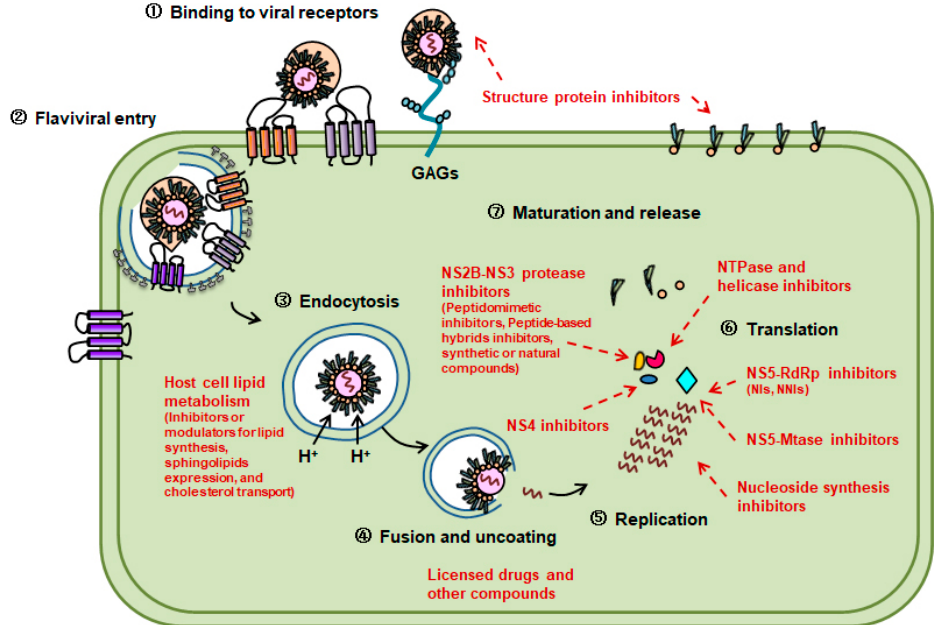
Figure 1. Flavivirus replication cycle and the targeted antiviral strategies. The virion binds to the surface of the host cell through specific receptors and is internalized into the host cell by clathrin- mediated endocytosis. Flavivirus is then uncoated, and its genome is released into the cytoplasm for the subsequent biosynthesis including replication and translation. After that, the virion is assembled and maturated for release. During these processes, various viral proteins and host factors participate in the flavivirus replication cycle, providing multiple antiviral targets for therapeutic interventions. Red words and lines indicate the antiviral agents targeting different viral proteins and host factors during flaviviral